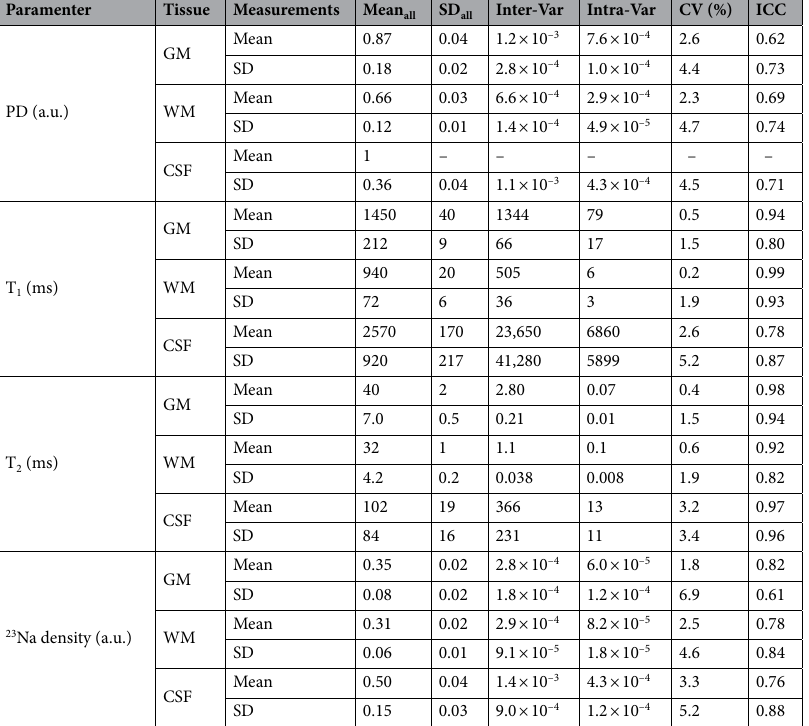
Paramenter Tissue Measurements Mean all SD all Inter-Var Intra-Var CV (%) ICC